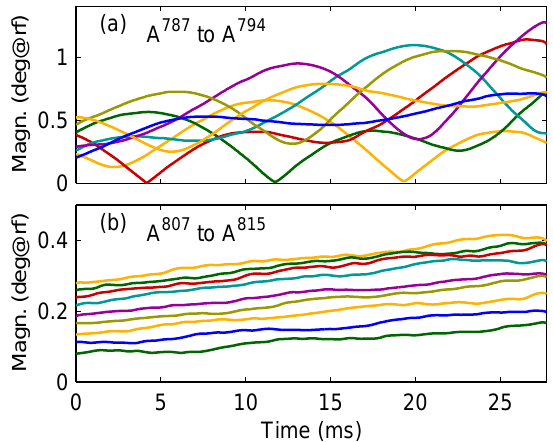
FIG. 7. (Color) Growth in magnitude of two sets of projections of a longitudinal instability transient in PEP-II LER. Uneven fill, I 0 (cid:1) 703 mA. (a) A 787 to A 794 , beating is evidence of at least two uneven-fill eigenmodes in this frequency range. (b) A 807 to A 815 , quasiexponential growth indicates that this set of sidebands oscillates coherently as a single